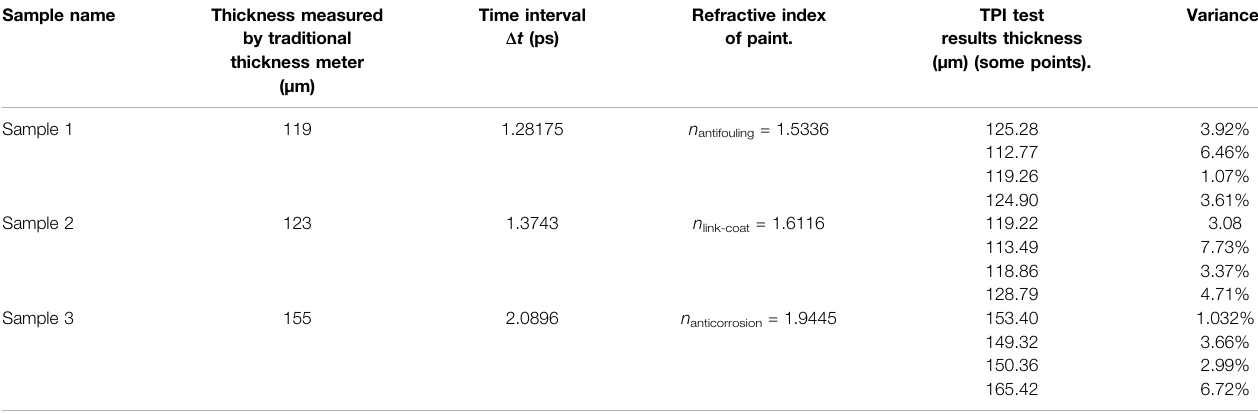
TABLE 1 | TPI test results of Sample 1, Sample 2, and Sample 3.